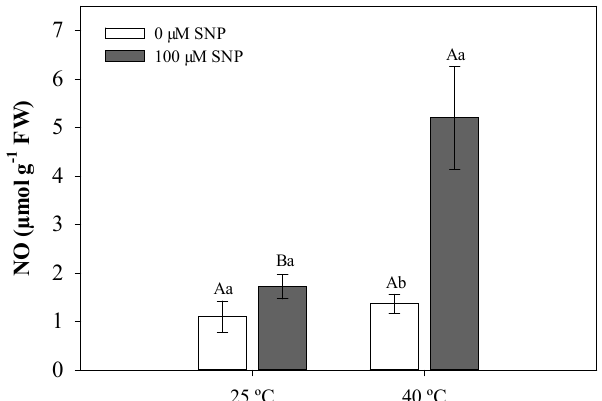
Figure 1. Nitric oxide (NO) content in soybean plants subjected to two temperatures (25 °C and 40 °C) and two sodium nitroprusside (SNP) concentrations (0 and 100 μ M). Bars represent means ( n = 5) ± standard error (SE). Capital letters (between temperatures) and lowercase letters (within temperatures) represent significant differences using Tukey’s test ( p < 0.05).